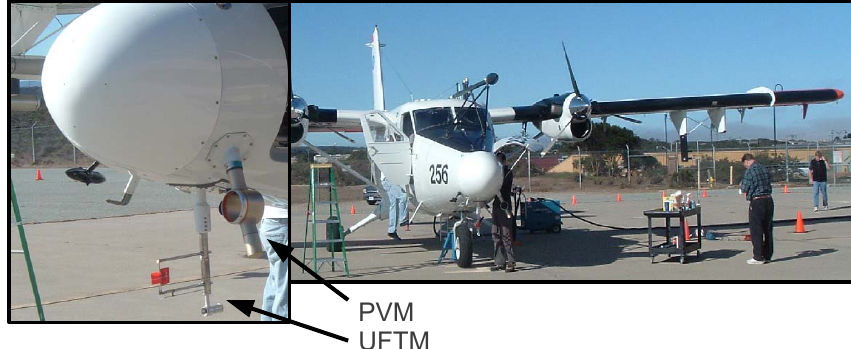
Fig. 3. UFT-M and other fast-response sensors mounted close together around the nose of the Twin Otter research aircraft during POST.